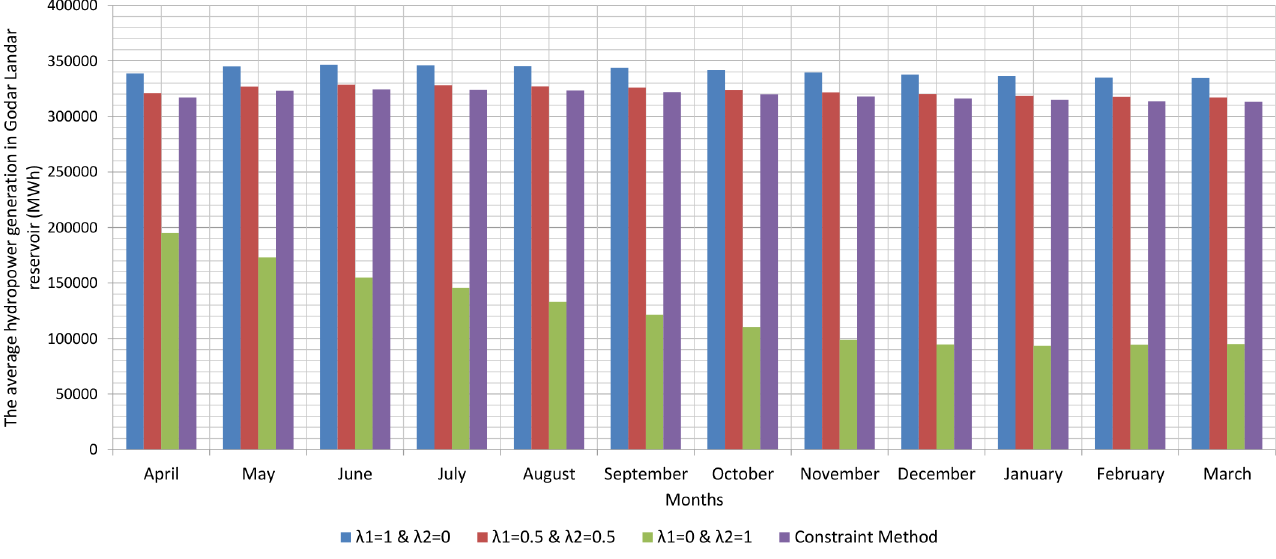
Fig 5. The average hydropower generation in Godar Landar reservoir